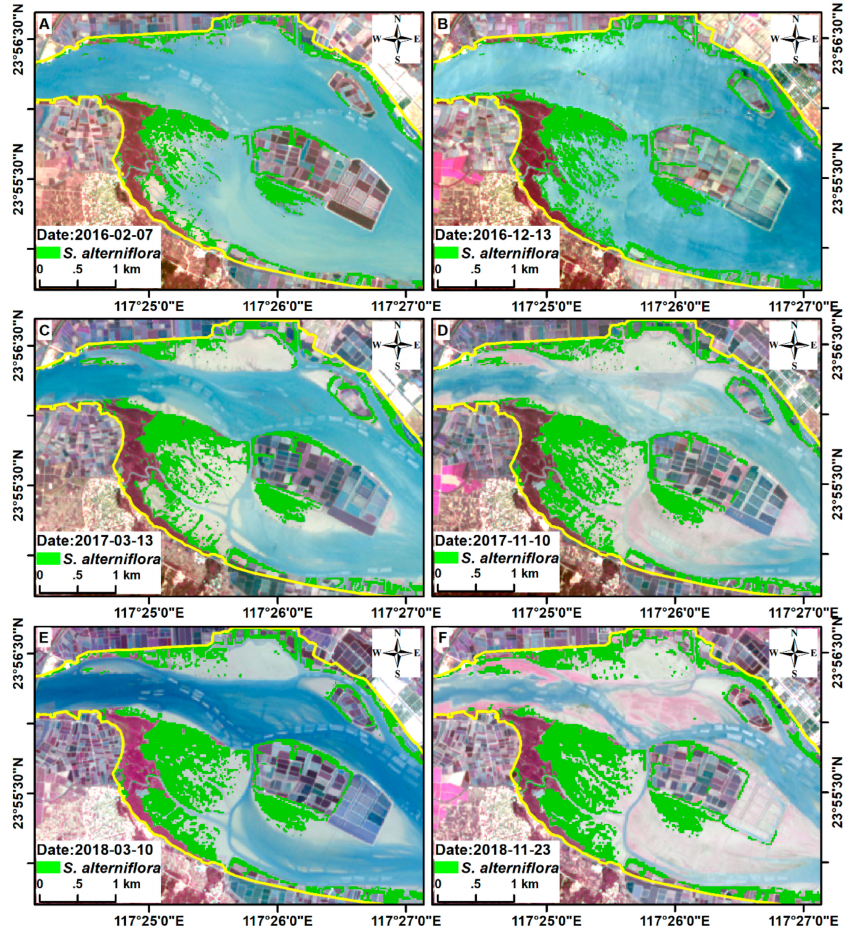
Figure 6. S. alterniflora distribution maps of the Zhangjiang Estuary from February 2016 to November 2018. Band combination: R:G:B = Sentinel-2 Band